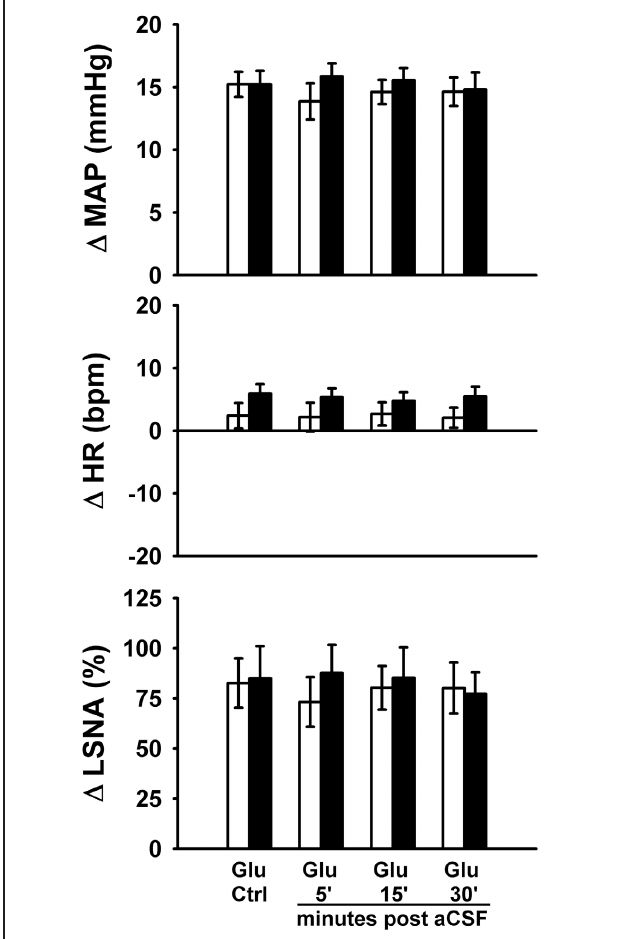
FIGURE 4 | Peak MAP, HR, and LSNA responses to activation of the rostral ventrolateral medulla with glutamate (10mM, 30nl) in the presence or absence of artificial cerebrospinal fluid injections (aCSF, 60nl). aCSF had no significant effect on responses in either sedentary (filled bars, n = 8) or physically active rats (open bars, n = 7) over the entire time course of injections and there were no significant differences between groups. Abbreviations are as defined in Figure 1